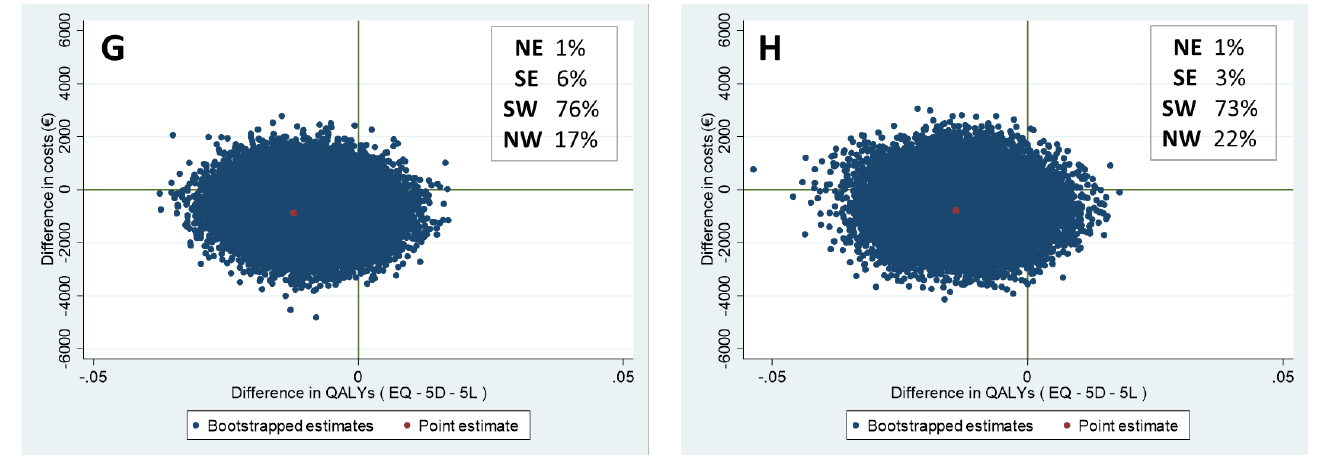
Figure 2 Cost-utility planes of the ( A ) base case analysis, ( B ) analysis with no correction for baseline EQ-5D score and costs, ( C ) complete case analysis, ( D ) analysis with intervention costs of €15, ( E ) analysis with intervention costs of €100, ( F ) analysis from healthcare perspective (only healthcare costs and intervention costs were taken into account), ( G ) analysis with imputed data for patients who died during the study, and ( H ) analysis excluding patients who died during the study.